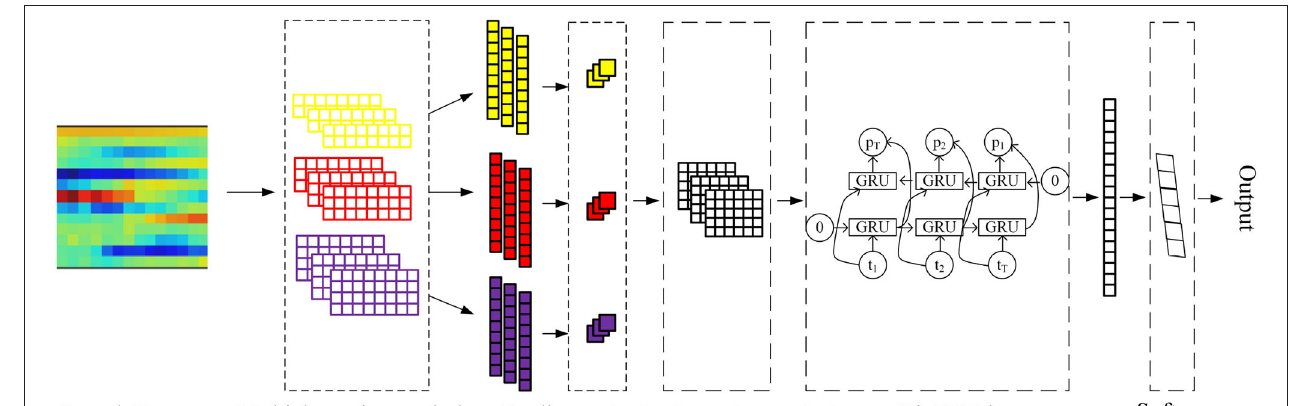
FIGURE 3 | 1D-CBBG